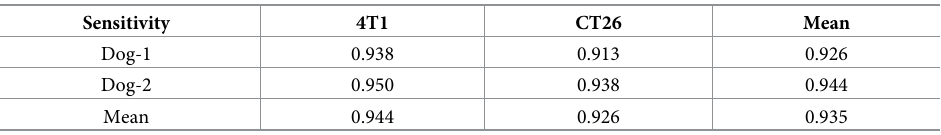
Table 3. Sensitivity by the two